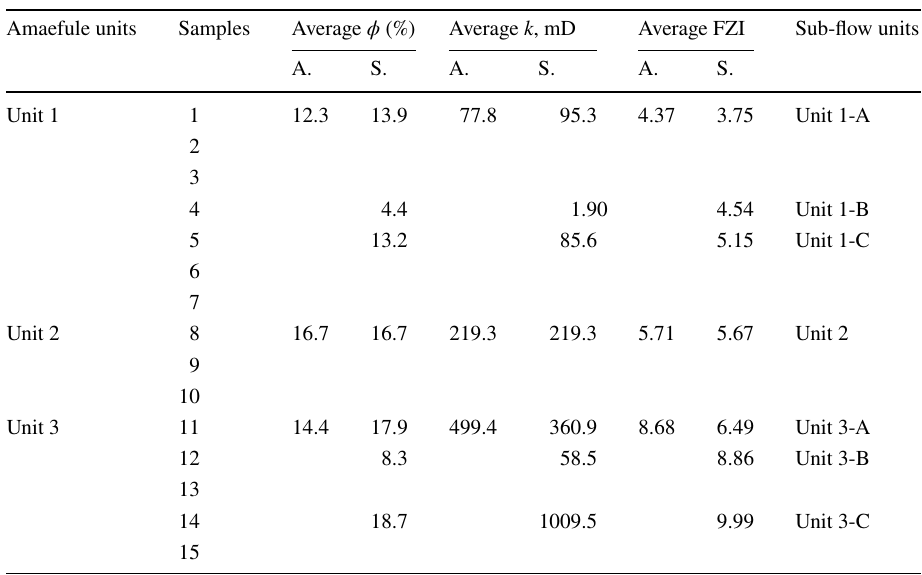
Table 3 Average porosity, permeability, FZI of studied samples for different flow/sub- flow units